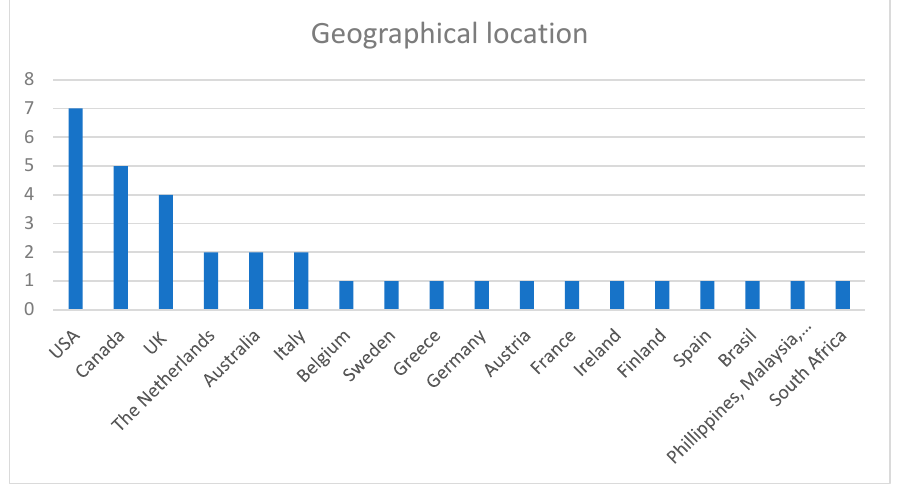
Scheme 1. Geographical location of the studies.